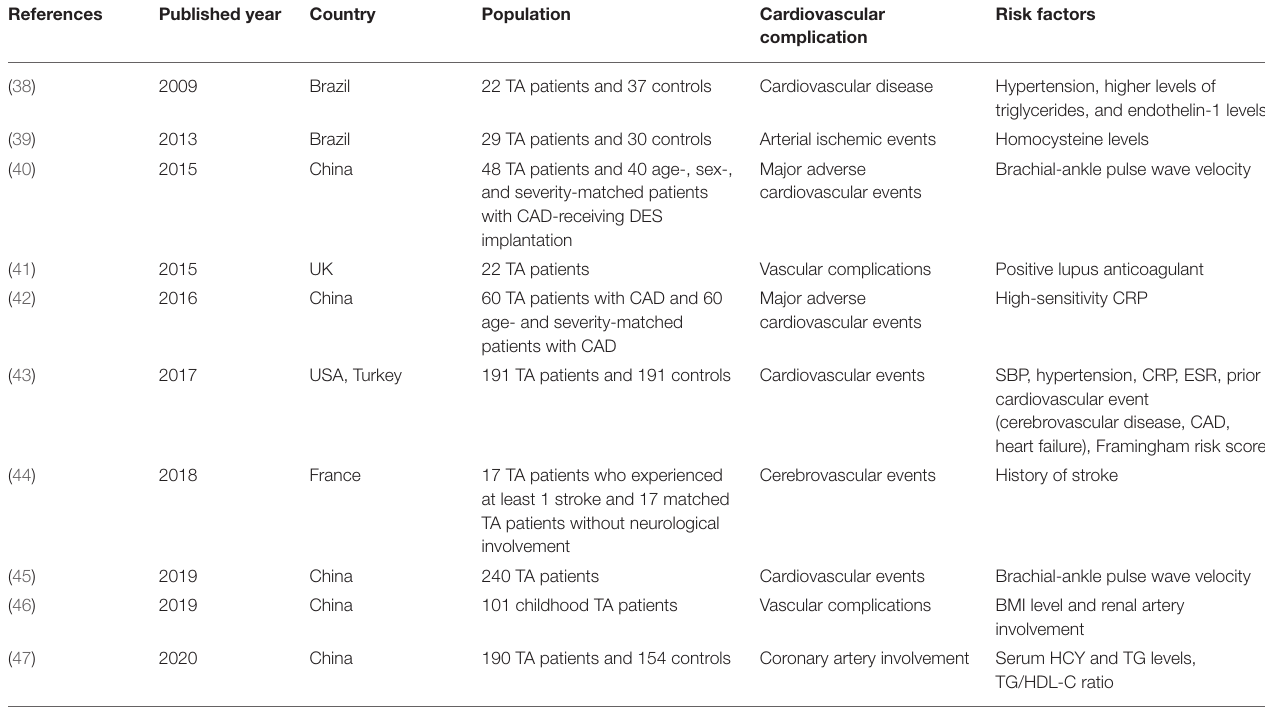
TABLE 1 | Previous findings of cardiovascular risk factors for TA